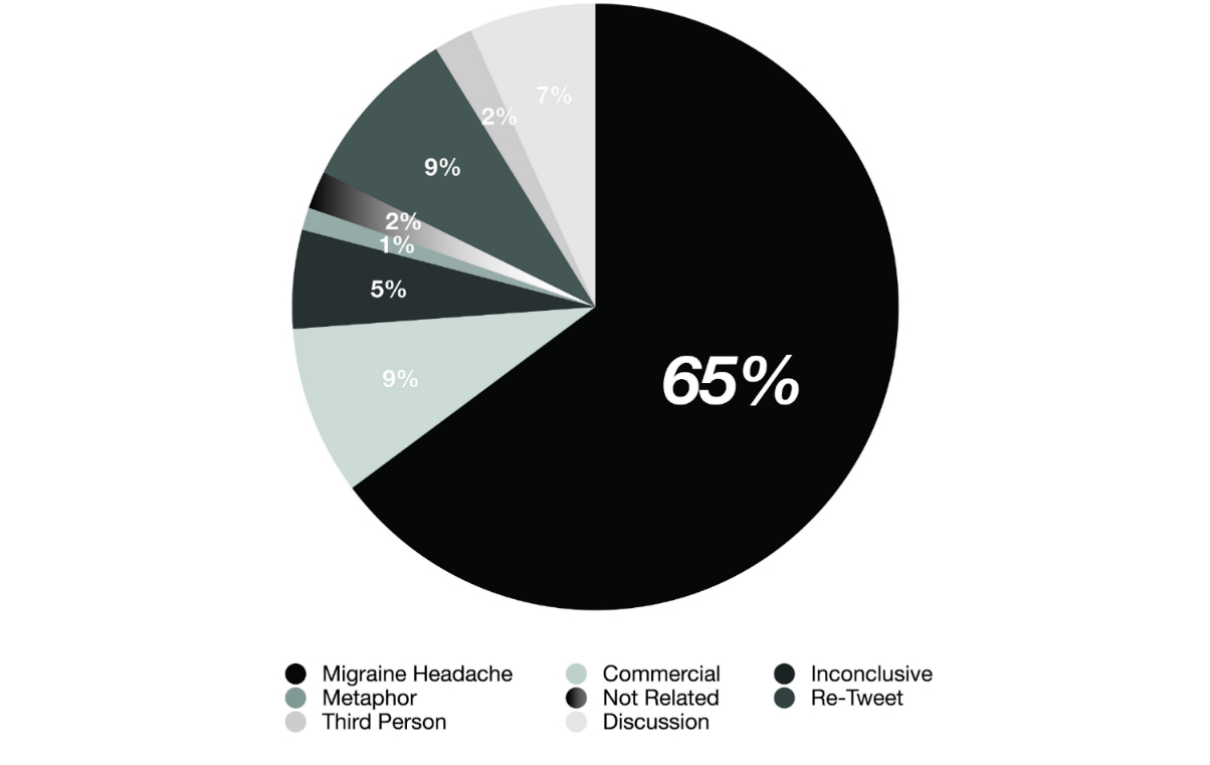
Figure 1. Classification of Tweets in Categories. Only 65% (14,028) of the 21,741 tweets were classified as self-reported migraine headache attacks.